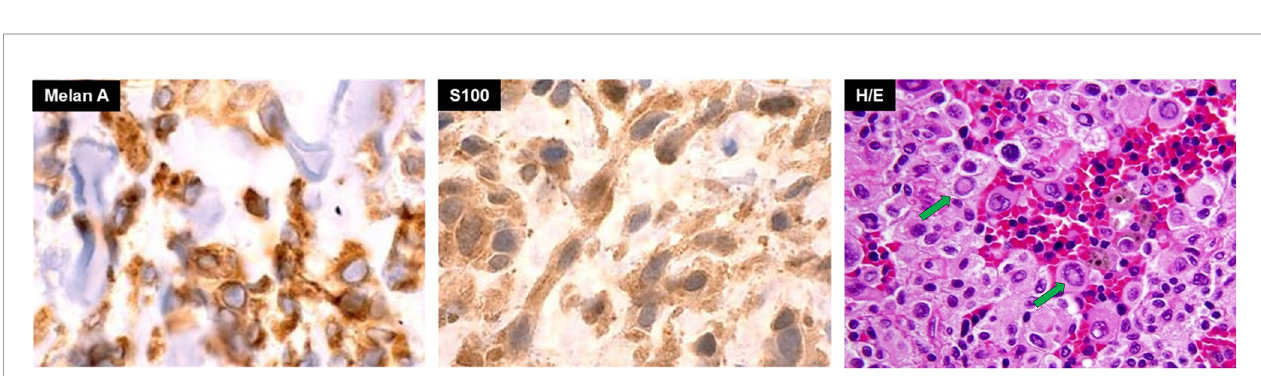
FIGURE 2 | Basal pathology of meningeal hyperpigmented lesion from the posterior fossa compatible with a primary melanoma of the meninges. Green arrows in H/E image show large nucleoli in cells with a high nucleus-cytoplasm ratio.